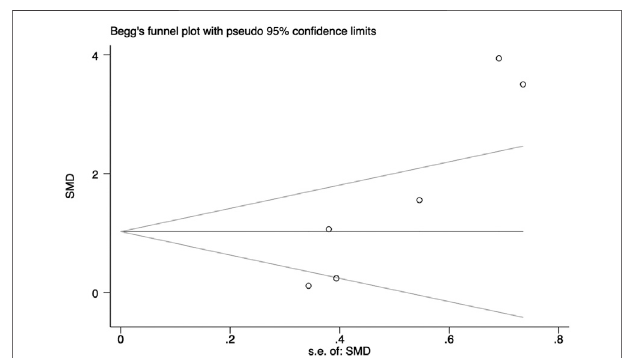
FIGURE 7 | Begg ’ s funnel plot of studies compared the ef fi cacy complared to placebo.